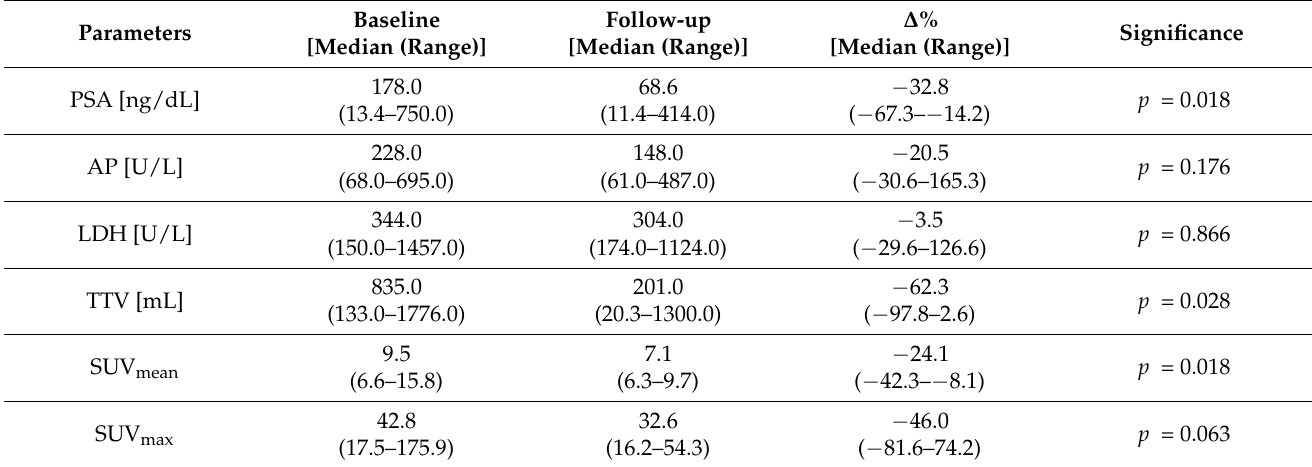
Table 4. Changes of image-derived and clinical parameters prior to and after two cycles of 225 Ac-